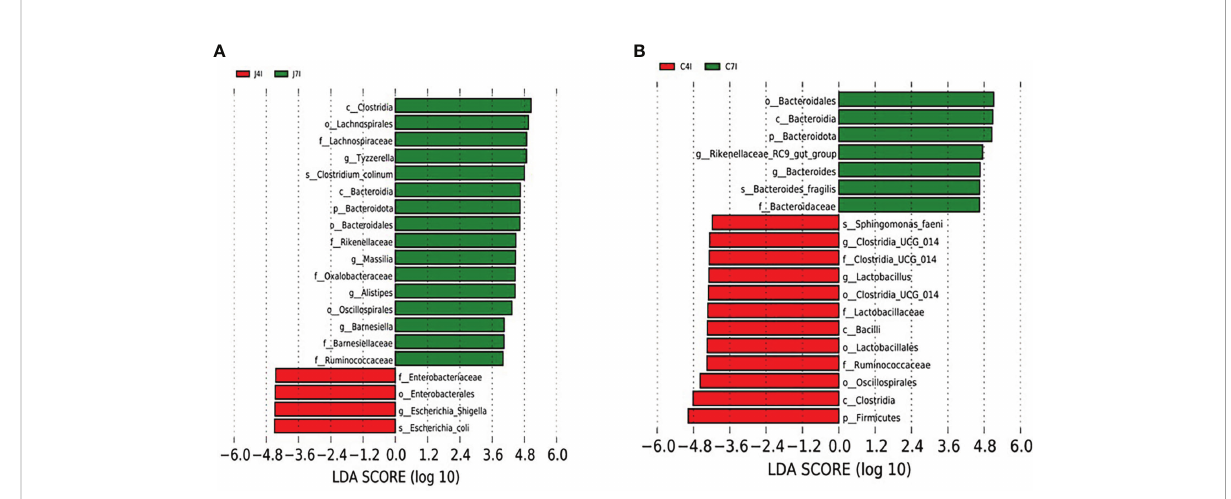
FIGURE 6 LEFSe analysis of differential OTUs along with the fourth- and seventh-day post-infection of jejunum and cecum groups. (A) Differential microbial enrichment of J4I and J7I (B) Differential microbial enrichment of C4I and C7I. The green and red horizontal colour bars represent microbial enrichment in the 4- and 7-days post-infection of jejunum and cecum,